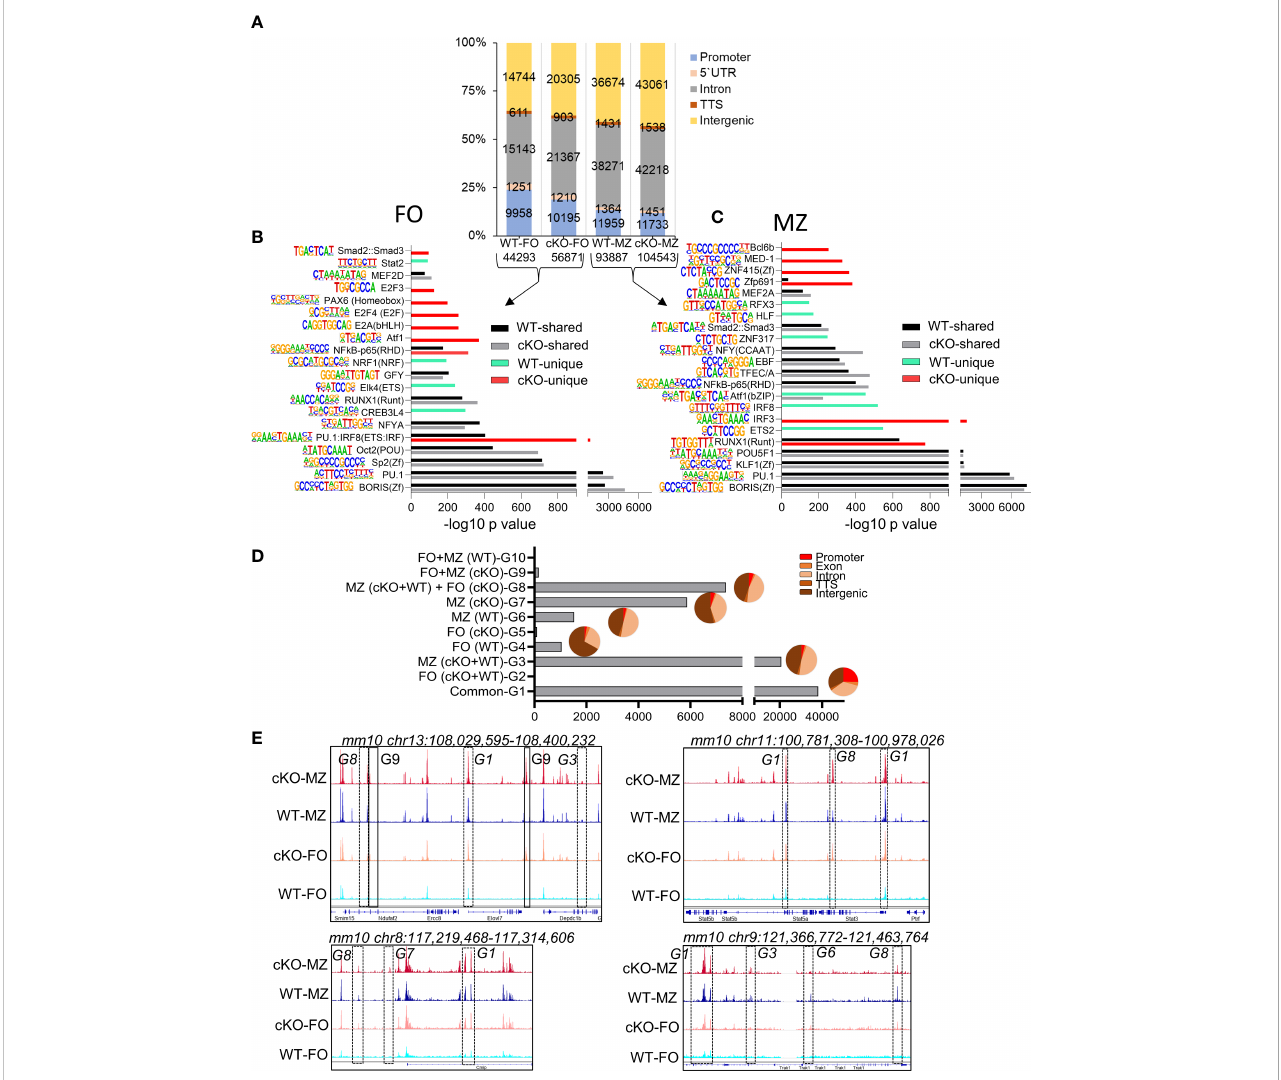
FIGURE 5 Chromatin landscape of FO and MZ B cells of WT and cKO mice. Quantitative description of chromatin landscape of four different splenic B cell populations: WT FO and MZ B cells and Gtf2i cKO FO and MZ B cells. (A) Peaks from FO and MZ B cells (numbers of peaks on bottom) from the indicated mouse strain and the annotations regarding their location in the genome. The peak numbers per region are shown inside each region (B, C) Presence of transcription factor motifs in open chromatin of WT and cKO FO (B) and MZ B cells (C) , bars represent the -log10 p-value. cKO selective transcription factor motifs are marked by red color columns while WT selective transcription factor motifs are marked by light green color columns. Motif logos are listed next to each transcription factor. (D) Overlapping peaks from all four populations were identi fi ed using mergePeaks.pl suite (with -d 50) in HOMER. Ten different clustered groups (G1 – G10) of the overlapping peaks are shown with their indicated properties on the y axis. The pie charts show the peaks distribution in the genomic regions for the speci fi ed groups. (E) Genomic tracks of open chromatin (snapshot from IGV genome track viewer) from indicated B cell populations demonstrating open chromatin regions of chromosome 13, 11, 8 and 9. Group speci fi c peaks are outlined by